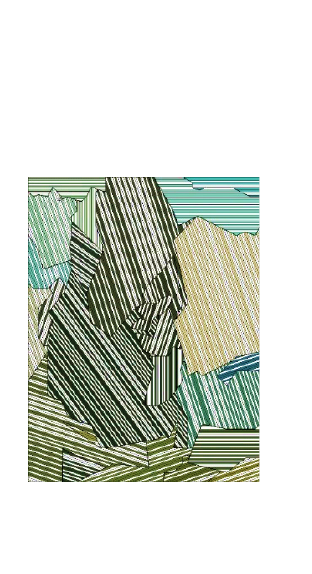
Figure 16. Experimental result 4. ( a ) An original image by Oleksandr Pidvalnyi [31]. ( b ) The result of image segmentation of ( a ). ( c ) The result of polygon approximation of ( b ). ( d ) Three Futurism- like images created from ( a ) with the stripe widths of 3, 6, and 9 pixels, respectively. ( e ) Three stego- images created from ( a ) by embedding the message “Make hay while the sun shines.” with the secret key “Positive” and the stripe widths of 3, 6, and 9 pixels, respectively.